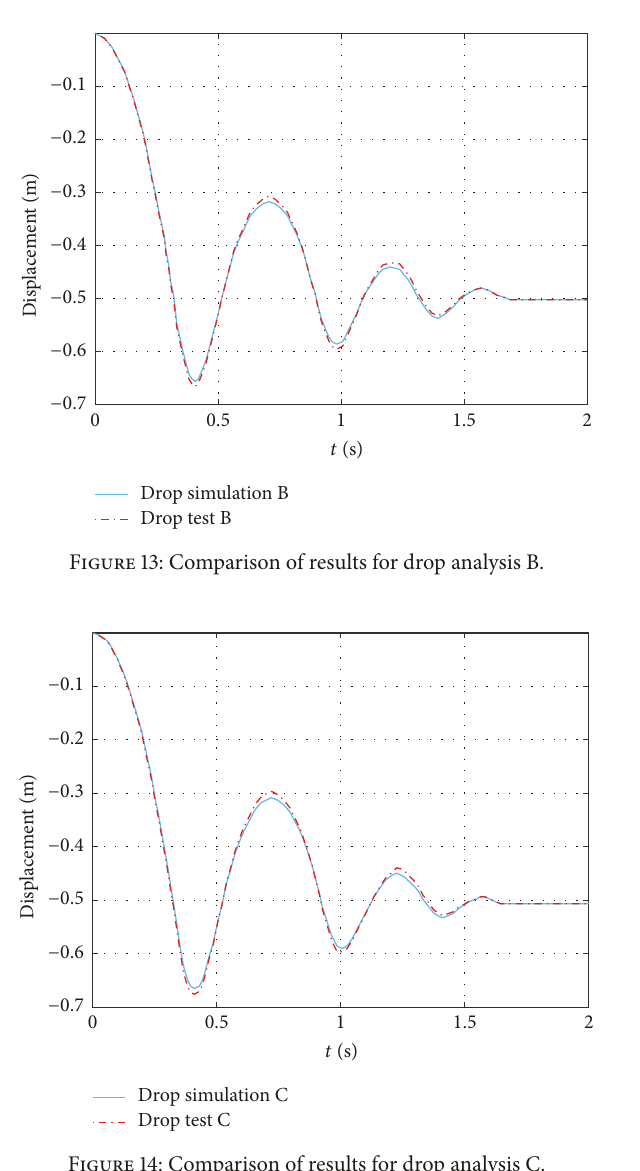
employed to predict the linear parameters with a frequency response function and the geometrically nonlinear parame- ters are identified by nonlinear static test with the nonlinear least squares